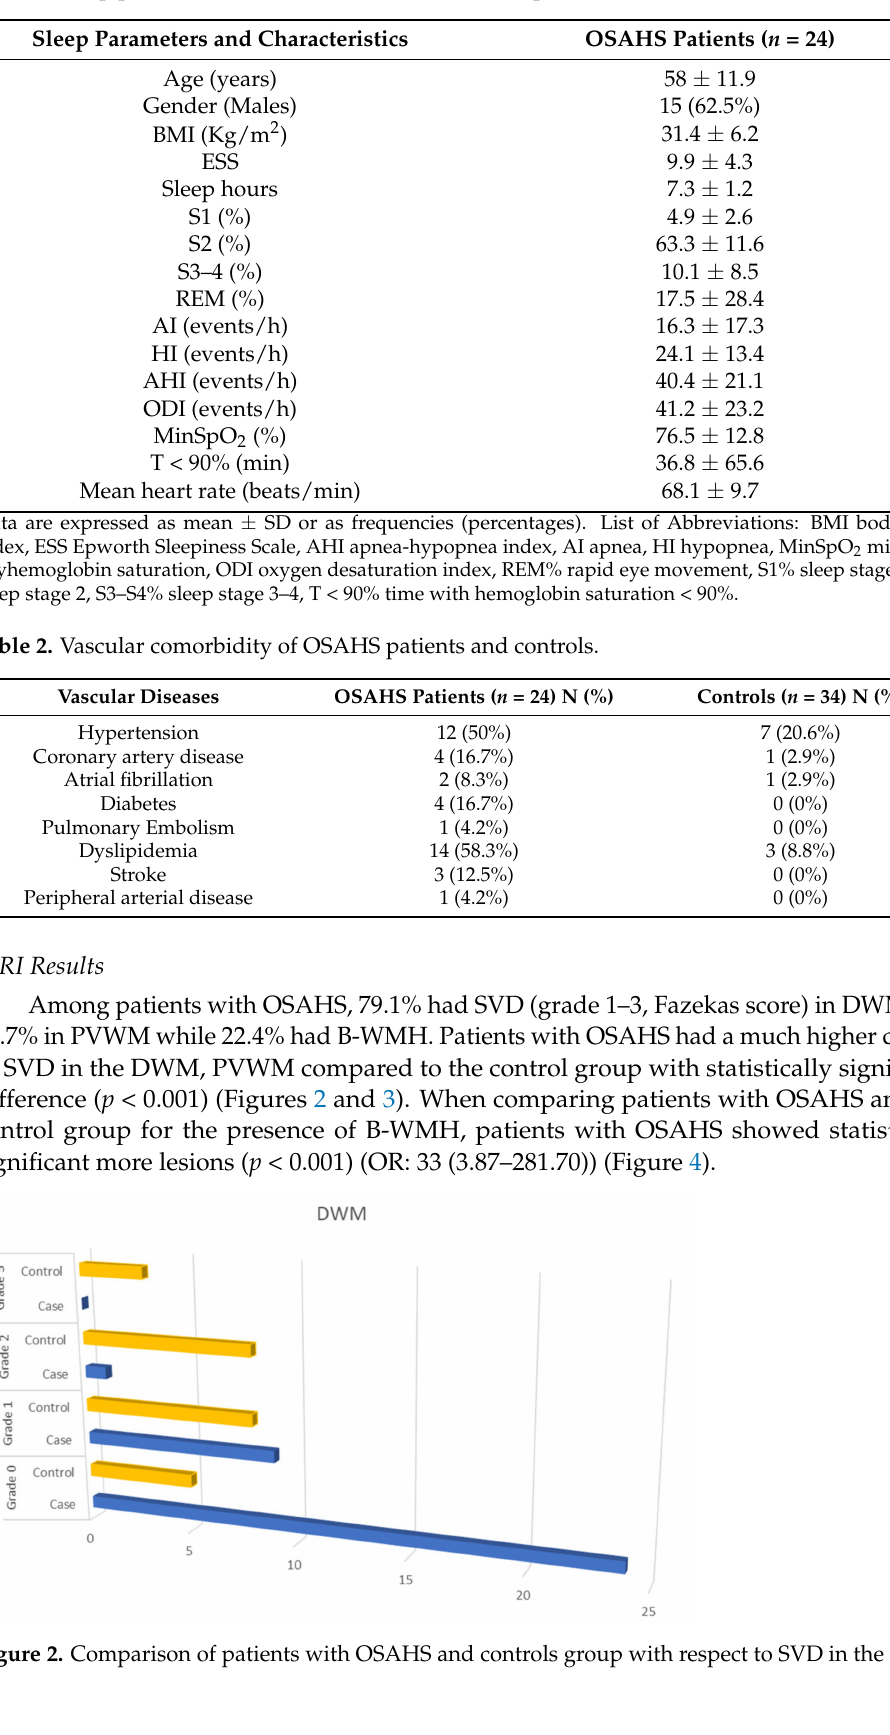
Table 1. Sleep parameters and characteristics of OSAHS patients.